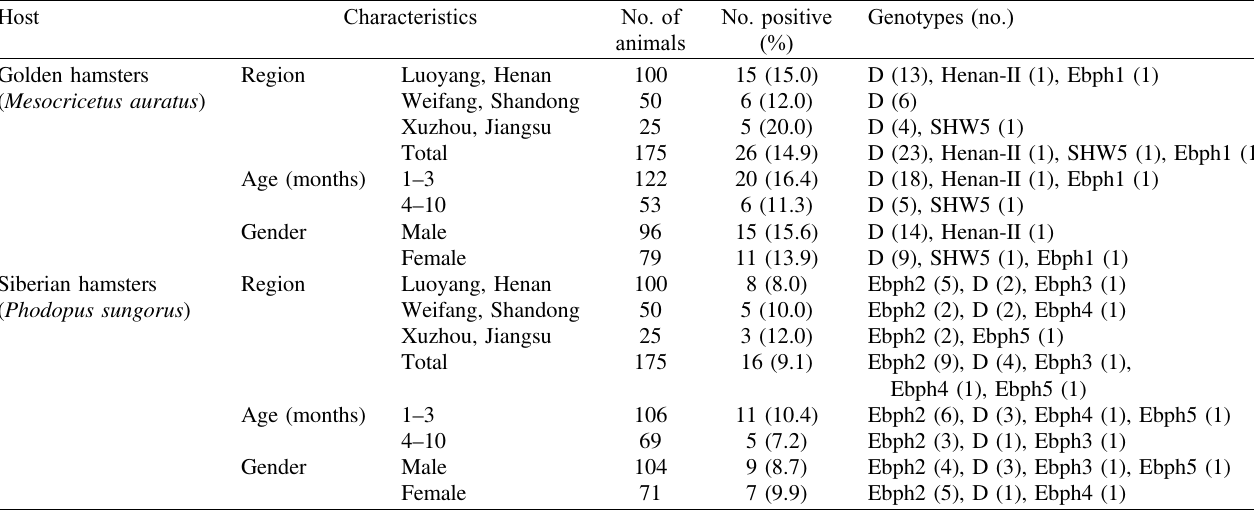
Table 1. Prevalence and genotypes of Enterocytozoon bieneusi in pet golden hamsters ( Mesocricetus auratus ) and Siberian hamsters ( Phodopus sungorus ) in